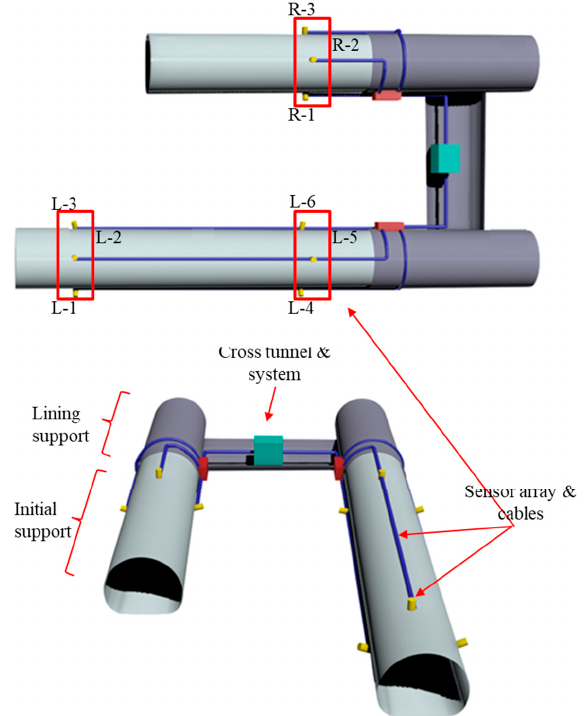
Figure 8. Microseismic monitoring system and arrangement of sensor arrays in the twin-tube tun-